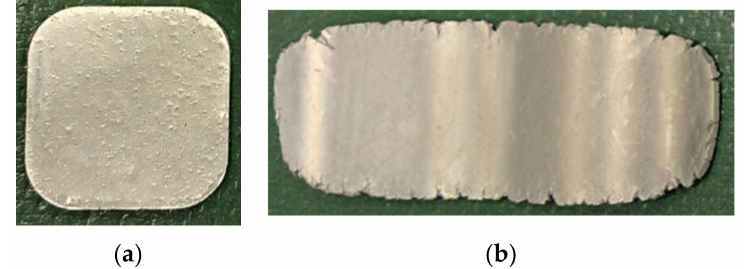
Figure 7. Sample photos: ( a ) before and ( b ) after repeated hot